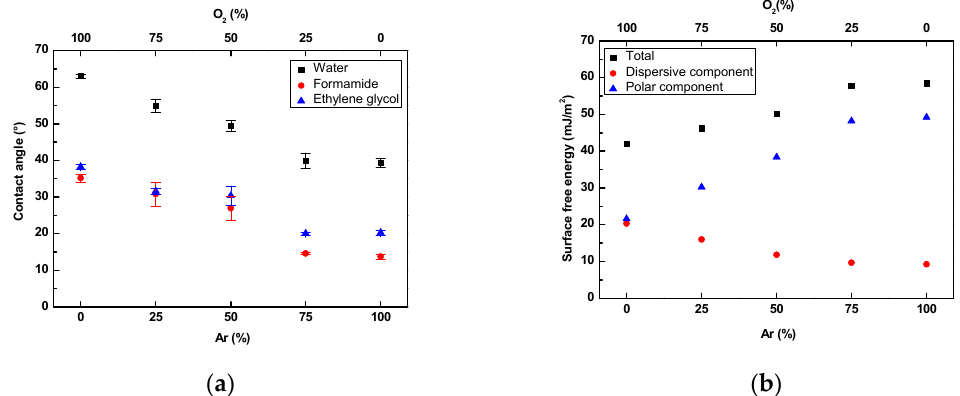
Figure 4. ( a ) Contact angle and ( b ) the surface free energy as a function of gas concentration for PU treated using Ar/O 2 plasma for 180 s.